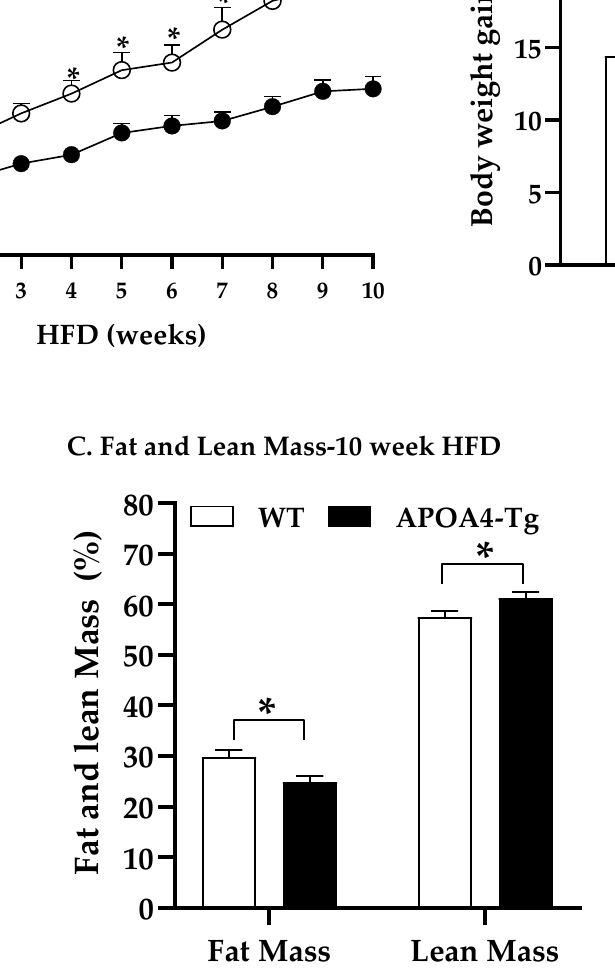
Figure 5. Body weight ( A ) in mice during a 10-week feeding of HFD, and body weight gain ( B ) and percent fat and lean mass ( C ) in mice after 10 weeks of HFD at 28 °C. Data are expressed as mean ± SEM for nine animals per group. Values with asterisks (*) represent significant differences relative to the WT mice ( p < 0.05). Table 3. Body weight, fat mass, and levels of plasma parameters in mice fed an HFD for 10 weeks.